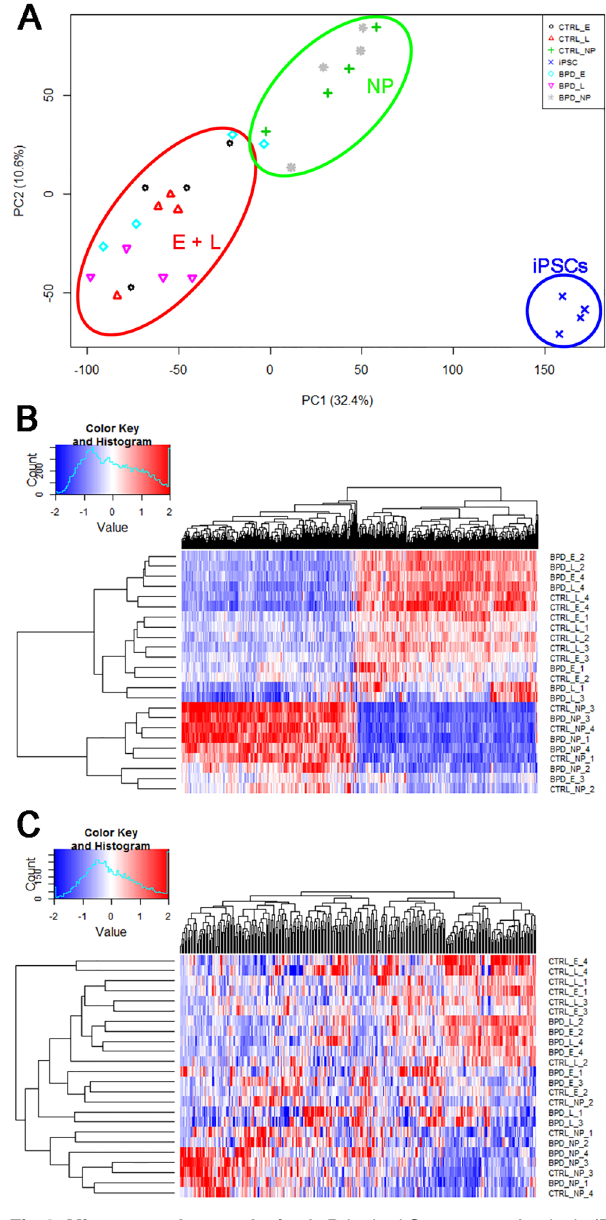
Fig 4. Microarray data analysis. A. Principal Component Analysis (PCA) plot shows three distinct clusters: iPSCs, NPs and E plus L neurons as outlined with blue, green and red lines, respectively. The symbols represent undifferentiated iPSCs (blue x), control NP (green cross; +), control E (black circle; ○ ), control L (red triangle; Δ ) and BPD NP (grey asterisk; * ), BPD E (turquoise diamond; ♢ ) and BPD L (pink inverted triangle; 5 ). B. Clustered heat map of differentially expressed genes in both control and BPD neurons demonstrates that the genes are clustered closely for E and L neurons regardless of disease status and separate from NPs and iPSCs. Horizontal axis shows genes used for clustering in the S2 Table and vertical axis shows sample clustering. C. Changes in expression of genes associated with axonal guidance (Ingenuity pathway analysis) shown as a clustered heat map show that the expression of genes associated with axonal guidance was higher in E and L neurons than in NPs. Horizontal axis shows genes used for clustering as listed in S3